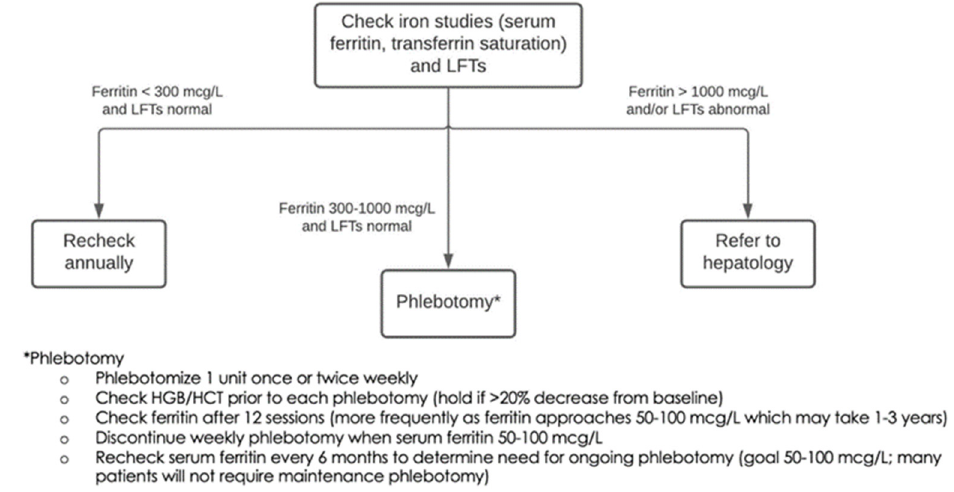
Figure 2. Diagram from our provider-facing information given to primary care providers for man- agement of hereditary hemochromatosis.